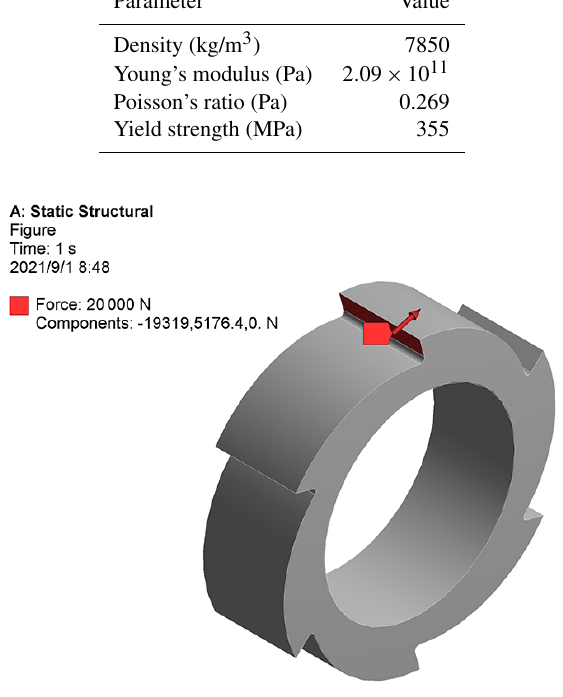
Figure 6. The application of the concentrated force.